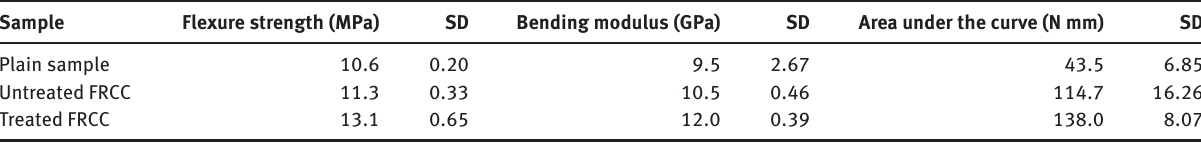
Table 4: Mechanical properties of FRCCs. Sample